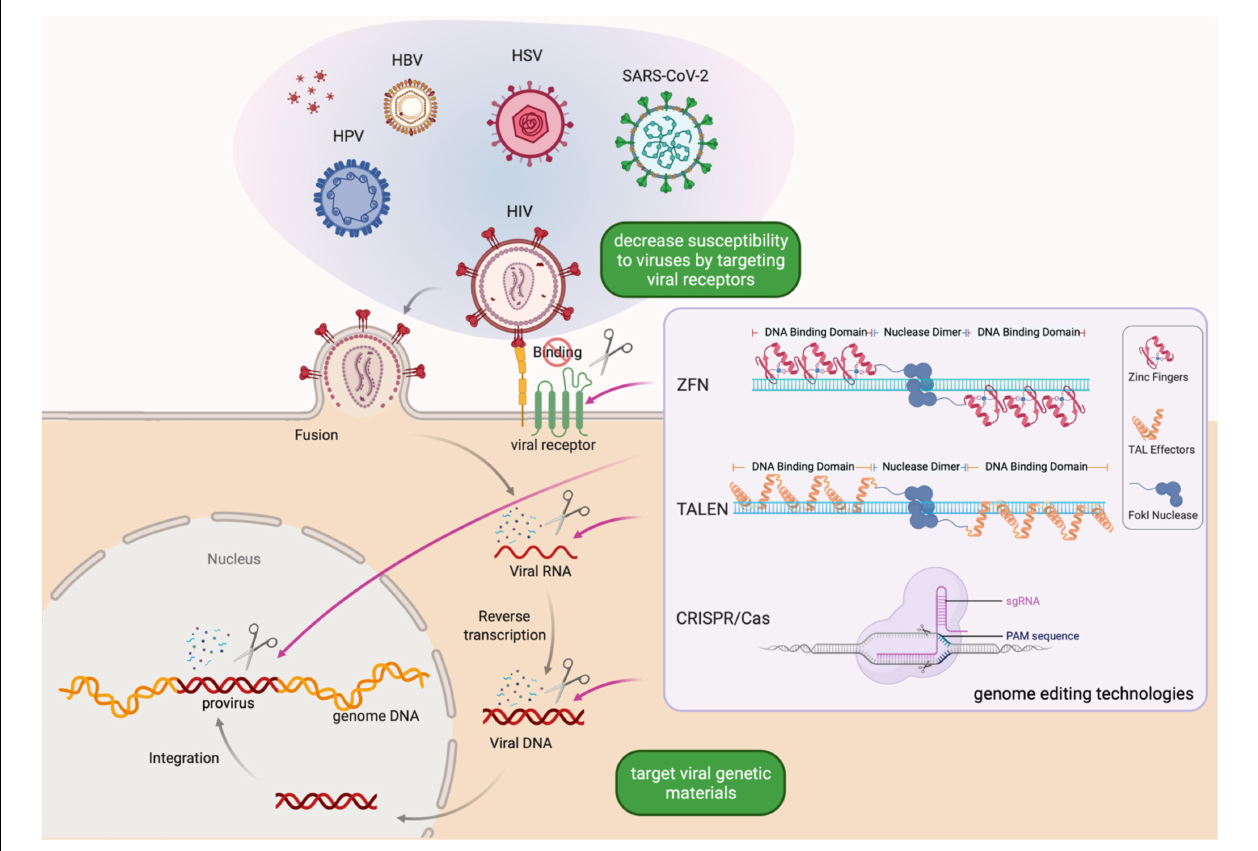
FIGURE 1 | Schematic of genome editing strategies for preventing or eliminating viral infections. Genome editing-based antiviral strategy is simple to design and can be quickly adapted to combat infection by a wide-spectrum of viral pathogens, aiming to eliminate latent infections and provide resistance to new infections. Created with